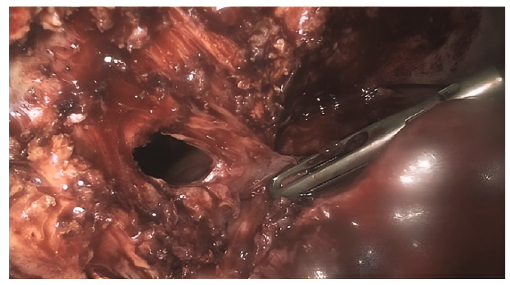
Figure 4: Abscess formation into the abdominal wall.